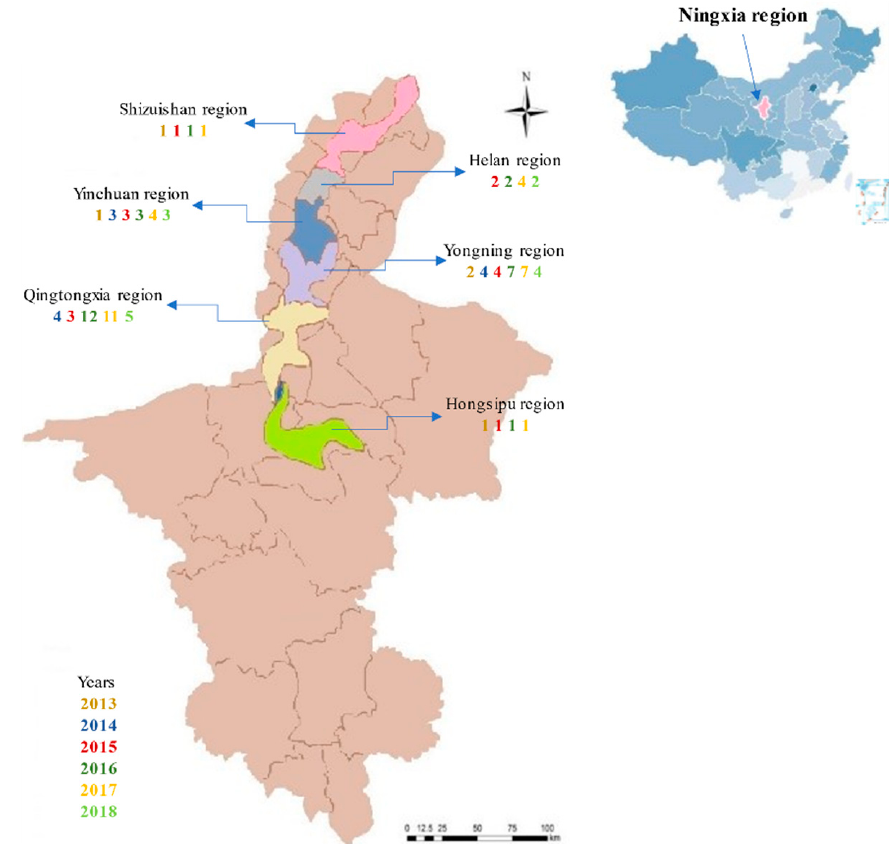
Figure 1. Distribution map of wine samples of six vintages (2013–2018), from the six sub-regions from the Ningxia region of China. (The colored numbers represent the number of samples from each vintage that were collected from each sub-region.).